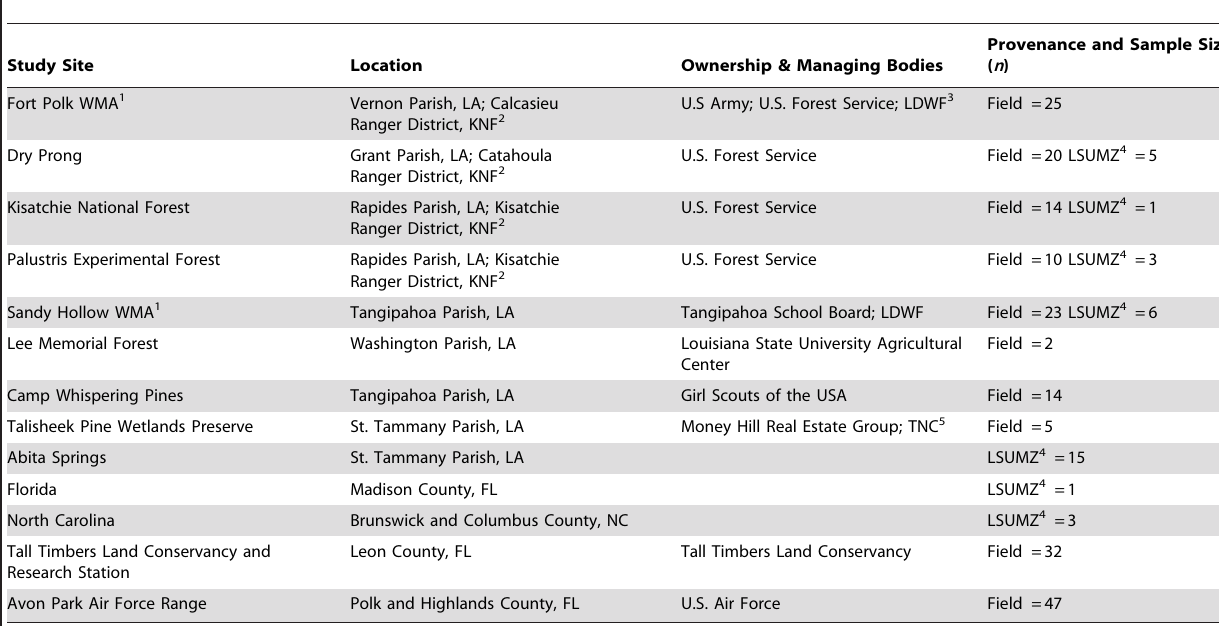
Table 1. Study site, geographic location, ownership and managing entity, provenance, and sample size for Bachman’s Sparrow